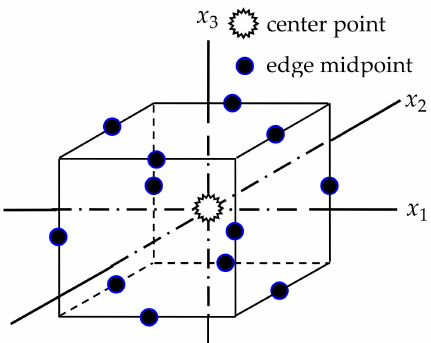
Figure 1. Box-Behnke samples of three